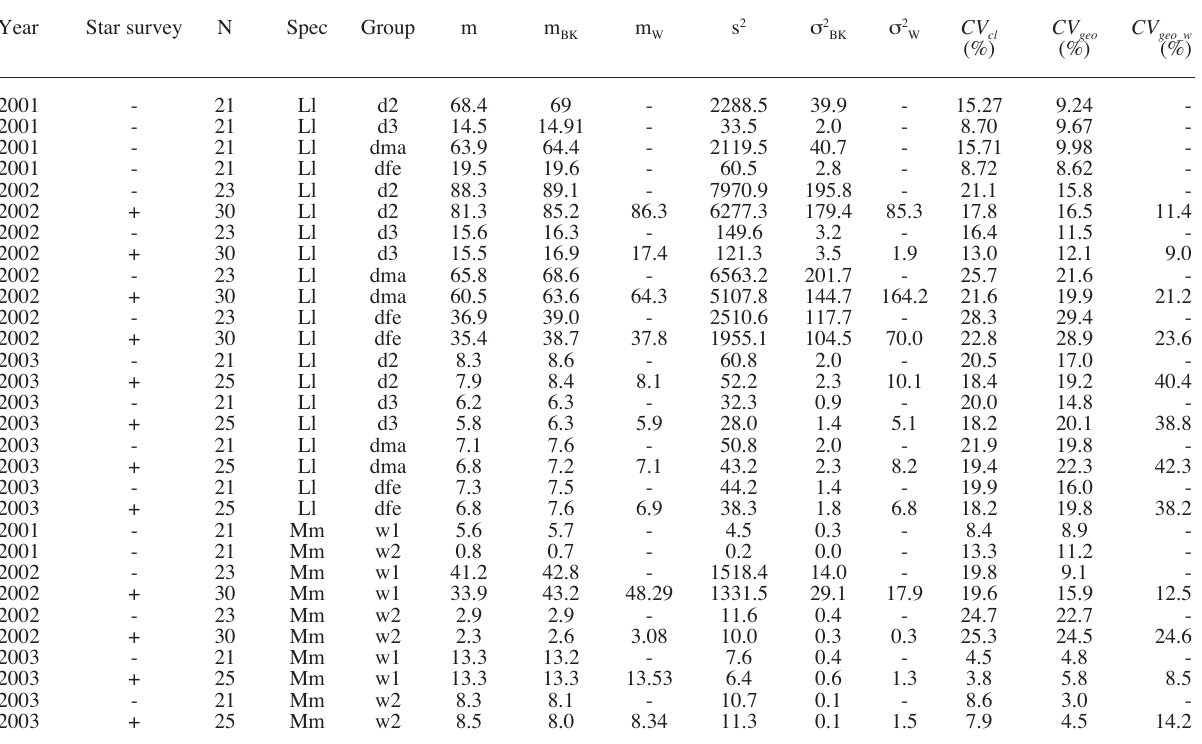
T ABLE 3. – Comparison of classical and geostatistical assessment of biomass indicators for dab and whiting in the German Bight (sampling area box A, Fig. 1). N: number of samples; m: arithmetical mean; m : kriged mean; m : weighted mean; s 2 : sample variance; σ 2 : geosta- BK W BK tistical estimation variance; σ 2 : geostatistical estimation variance, which takes clustered samples into account; CV : classical coefficient of cl W : geostatistical coefficient of variation of the arithmetic mean; CV : geostatistical coefficient of vari- variation of the arithmetic mean; CV ge o ge o_w ation of the arithmetic mean, which takes into account clustered samples (see Methods section for details); otherwise as in Table